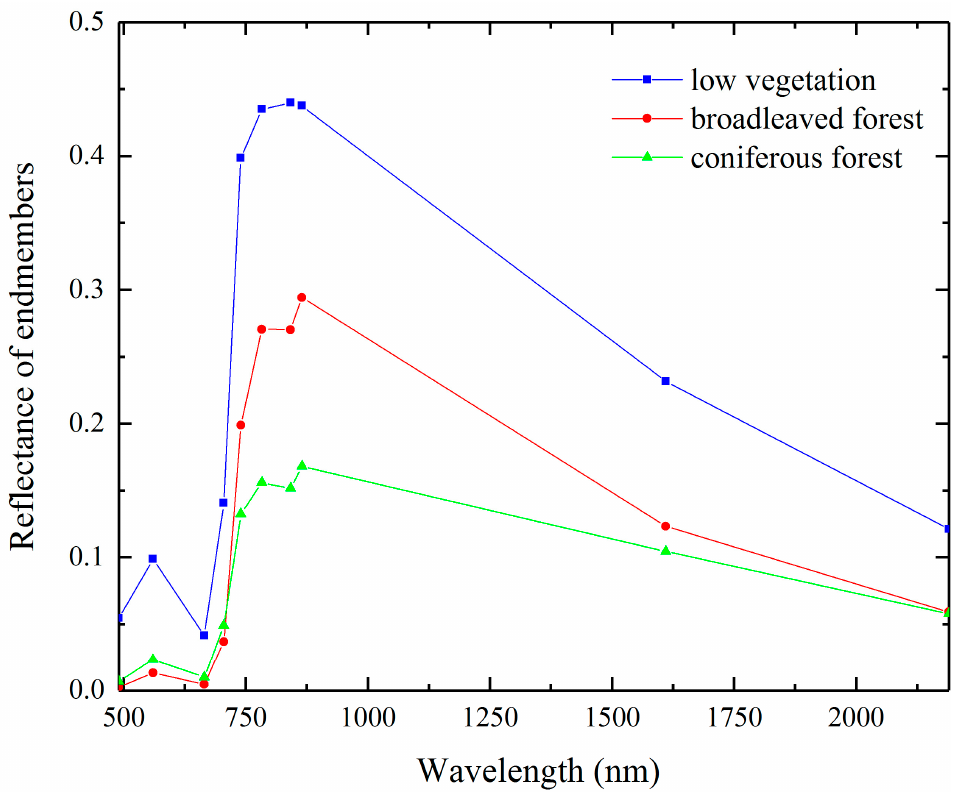
Figure 4. Spectra of three vegetation endmembers.